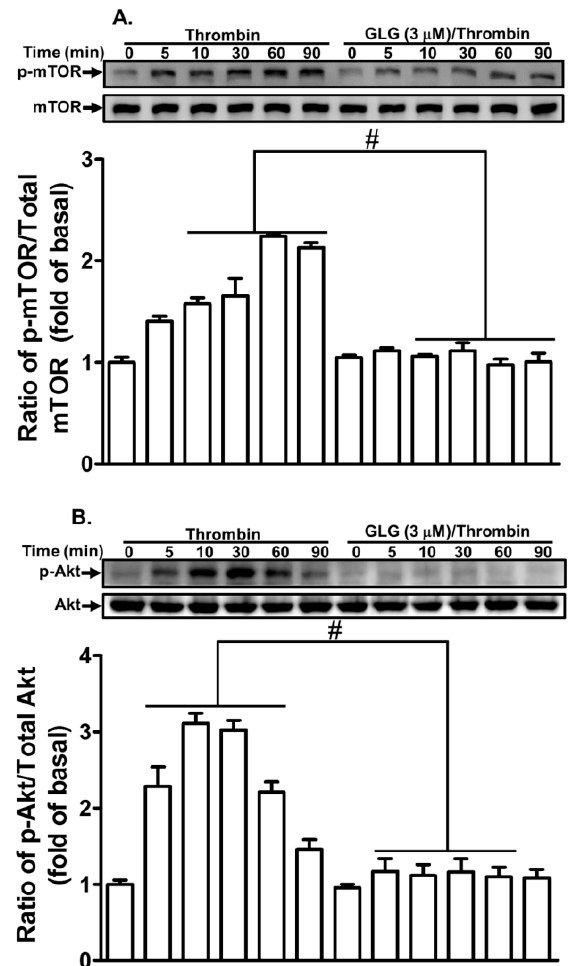
Figure 4. Galangin inhibits thrombin-induced phosphorylation of Akt and mammalian target of rapamycin (mTOR). The cells were pretreated with galangin (3 μ M) for 1 h and then challenged with thrombin (10 U/mL) for the indicated time intervals. The levels of ( A ) mTOR and ( B ) Akt phosphorylation and their respective protein levels were determined by western blot. The data are expressed as mean ± SEM of three independent experiments. * p < 0.05; # p < 0.01, as compared with the cells exposed to thrombin alone.